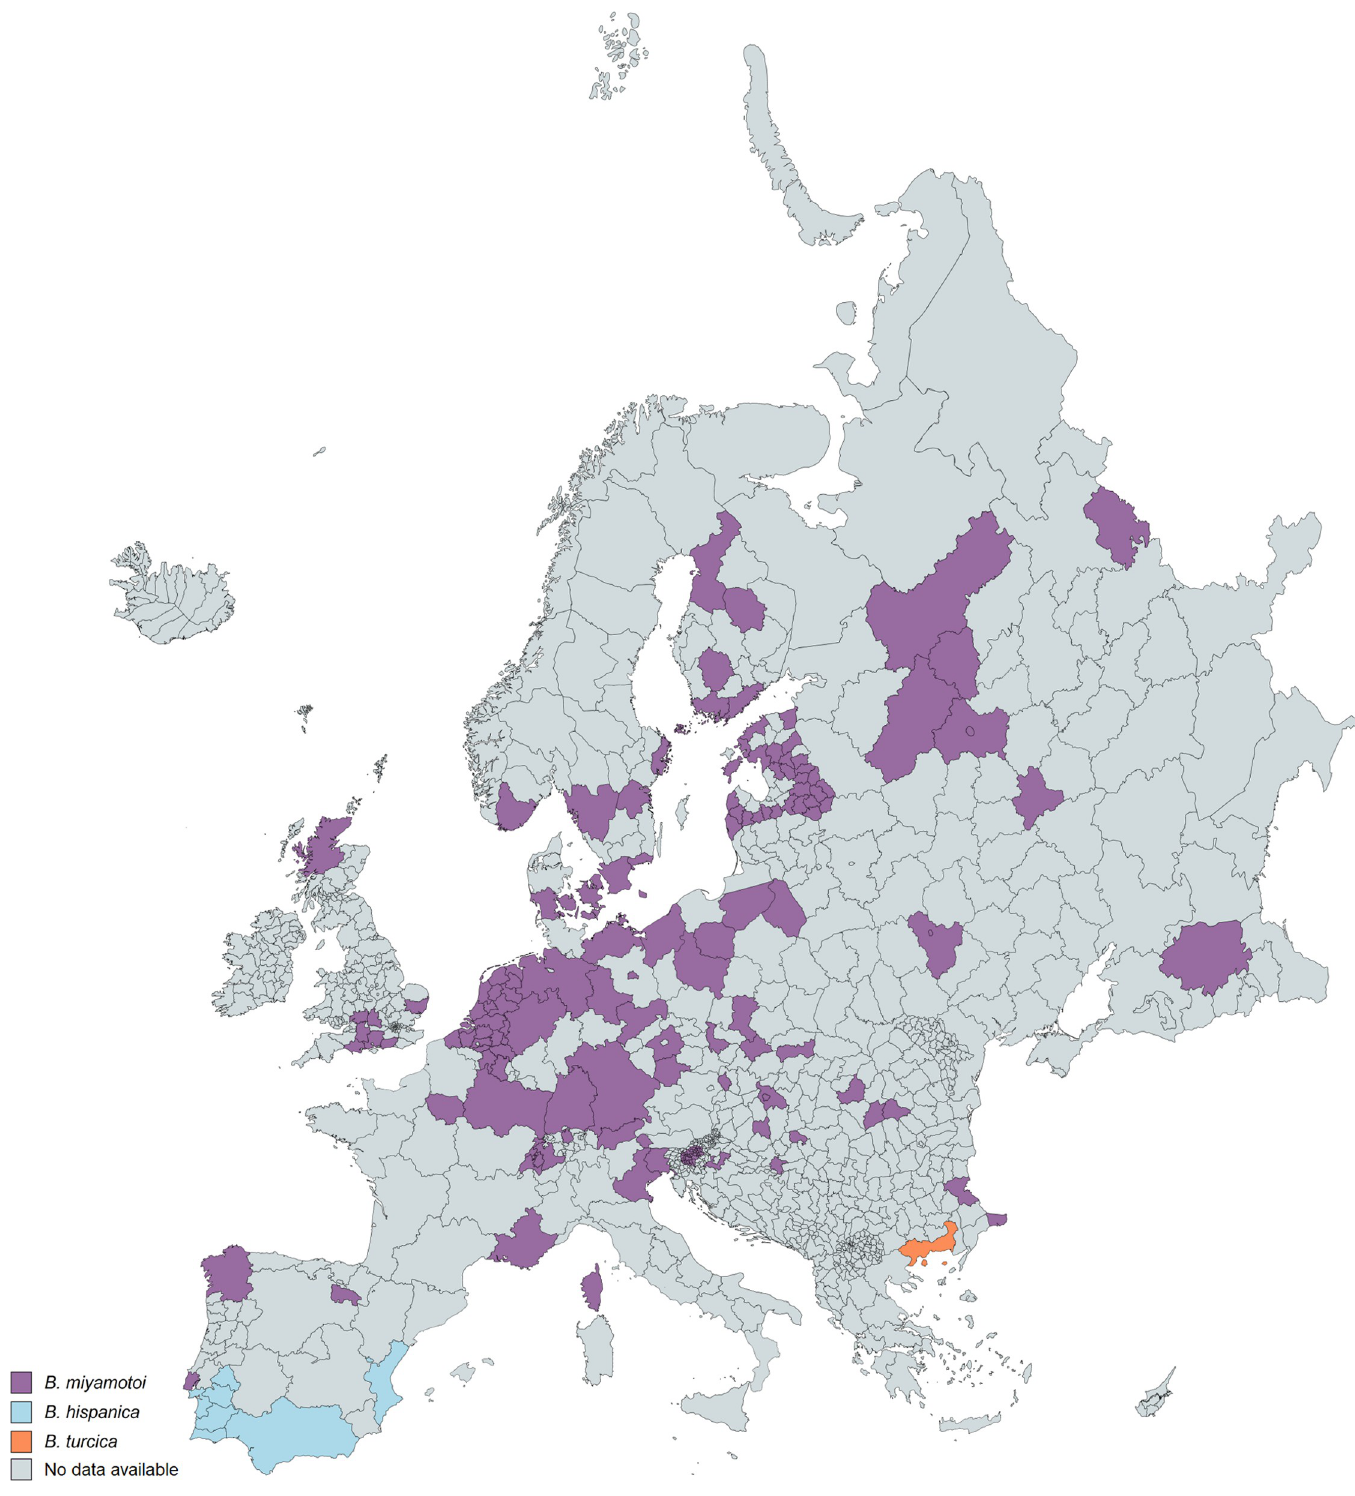
Fig 9. Reported presence of TBRF Borrelia species in ticks and animal hosts in Europe. B., Borrelia . Map created on www.mapchart.net.